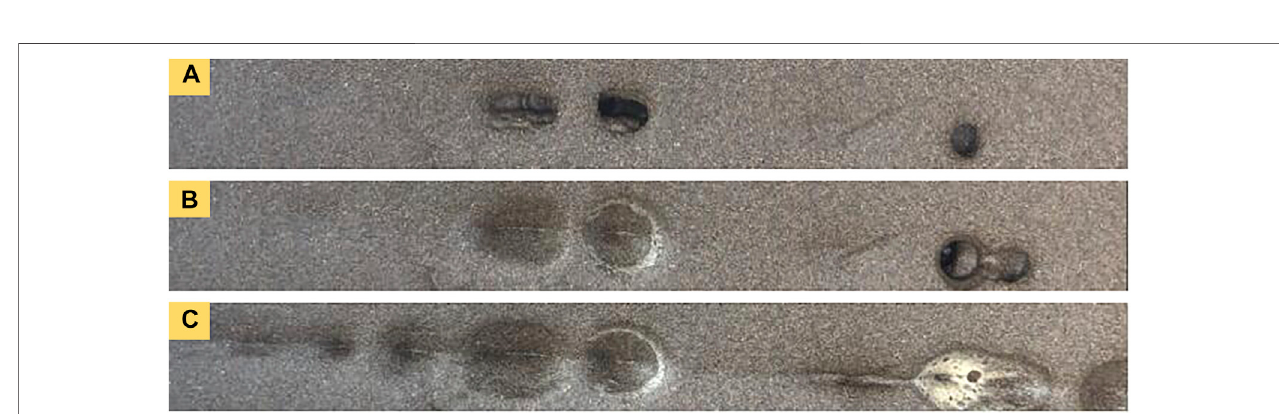
FIGURE 7 | Test phenomena of the sand surface under subsurface erosion. (A) After three water reserve – discharge cycles; (B) after fi ve water reserve – discharge cycles; and (C) after ten water reserve – discharge cycles.